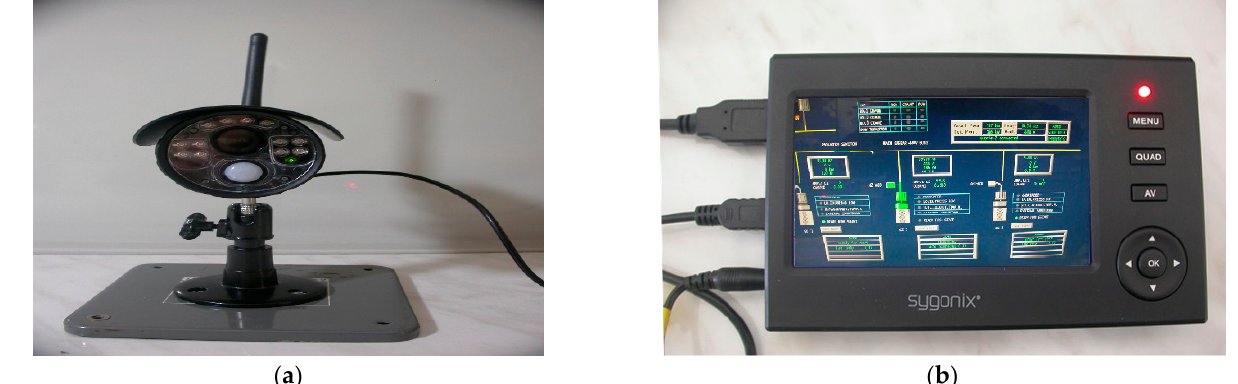
Figure 5. Recording camera ( a ) and monitor ( b ) showing generating set loads.